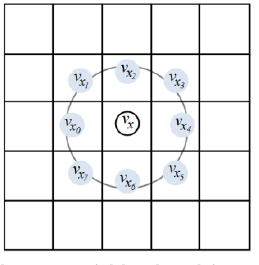
Figure 3. The 3×3 neighborhood in LBP